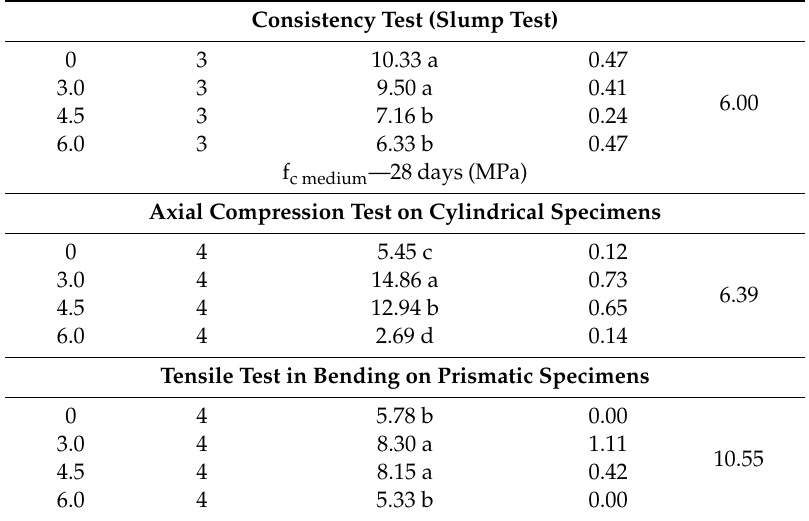
Table 2. Strength grade of di ff erent concrete used for concrete silo construction [29].